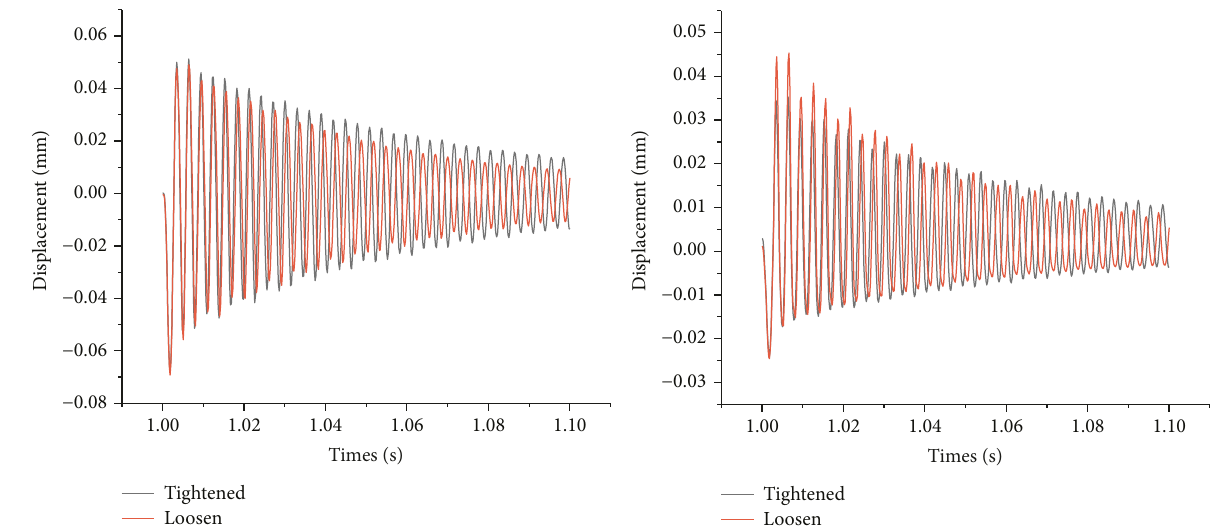
Figure 22: X and Y direction displacement response (under 1.5kN impact load on the top).